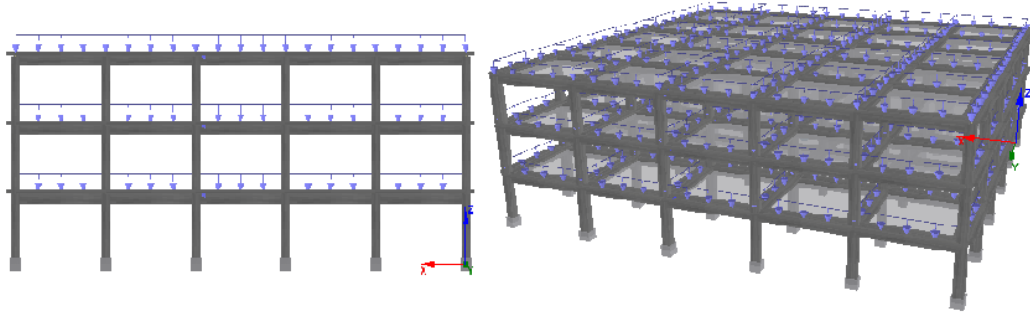
Figure 8. Two- and three-dimensional models of the selected 3-story RC building.